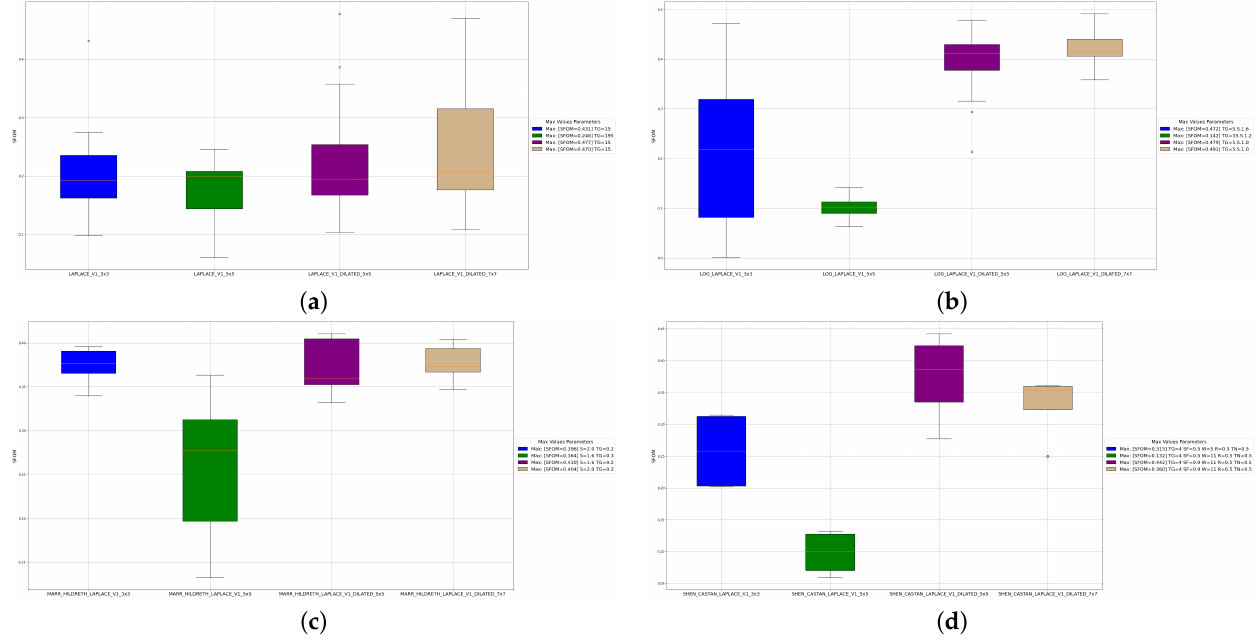
Figure 10. Finding the best results for classic, extended and dilated using different parameters for: ( a ) Laplace edge operator; ( b ) LoG edge operator; ( c ) Marr–Hildreth edge operator; ( d ) Shen–Castan edge